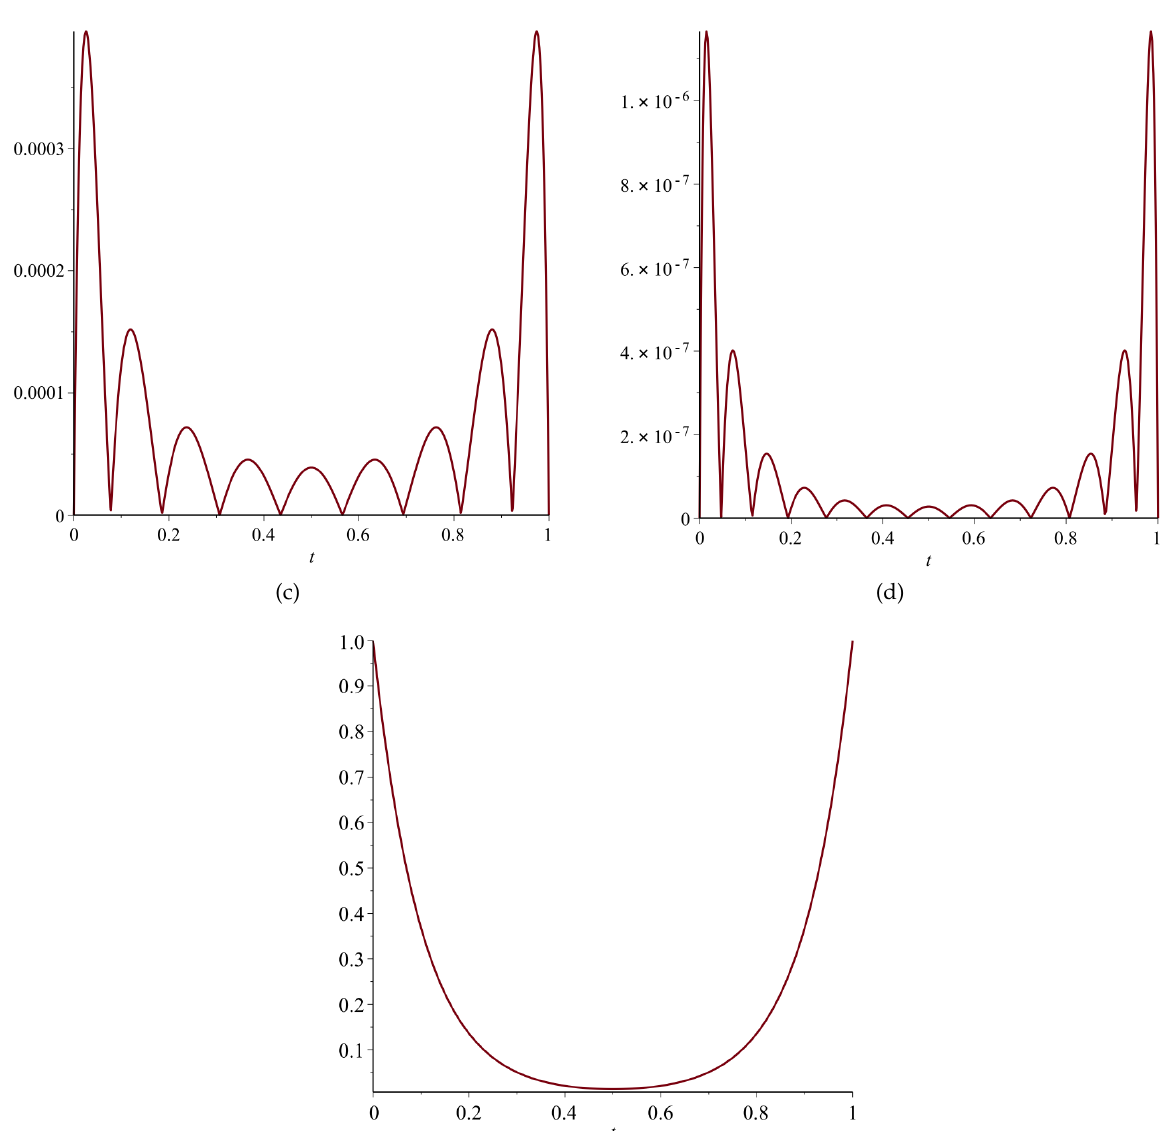
Fig. 2. The absolute errors | e N ( t ) | for (c) n = 8 and (d) n = 12 and (e) approximate solution u ( t ) of Example